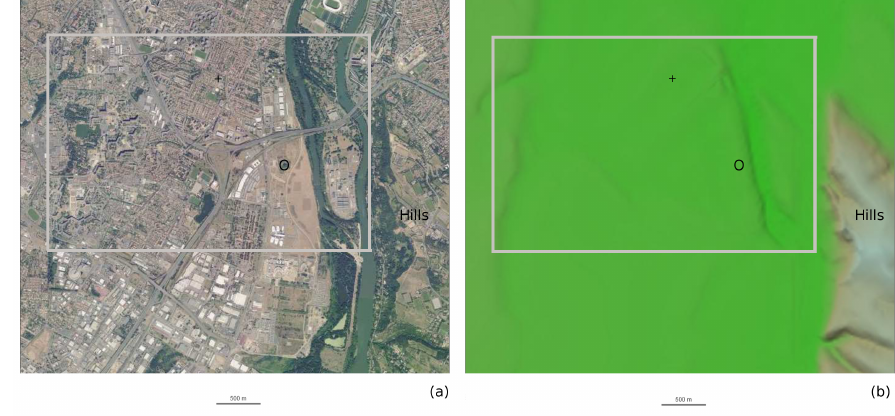
Figure 1. ( a ) Aerial photograph of Toulouse and its hilly region (www.geoportail.gouv.fr); ( b ) Topographic map of the same zone. The MNH-IBM study area is bounded by a grey contour. The black circle indicates the location of the factory and the black cross indicates the Jacquier station. The green color indicates a near-flat terrain with a 150 m altitude above sea